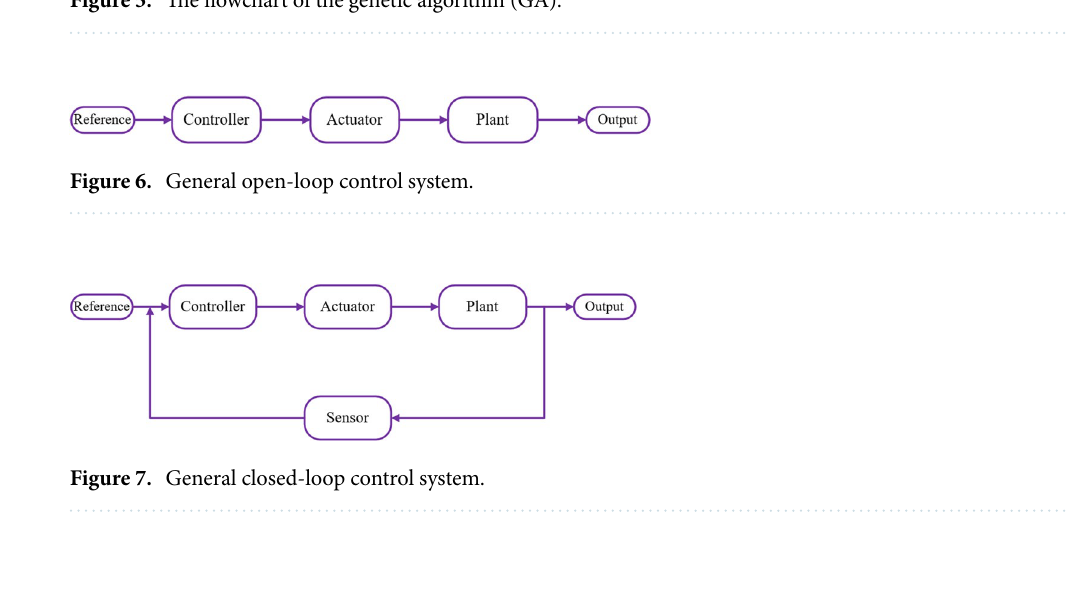
Figure 5. The flowchart of the genetic algorithm (GA).